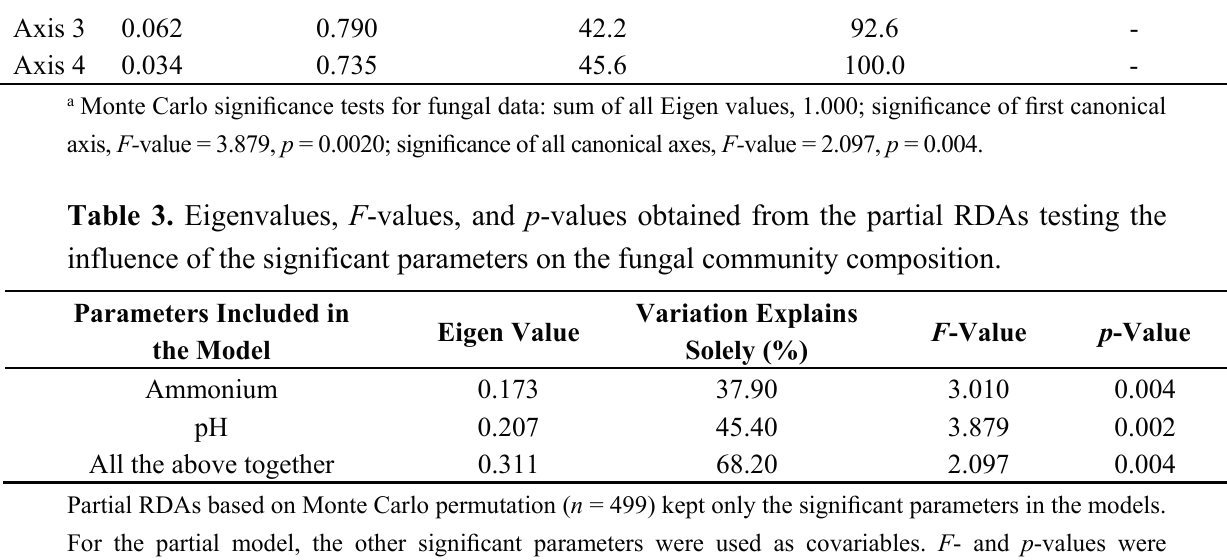
Table 2. Redundancy analysis results of surface and bottom fungal DGGE pro fi les a . Cumulative % Cumulative % Sum of All Eigen Species-Environment Variations of Variations of Canonical Axis Value Correlation Species Species-Environment Eigenvalue - - - - - 0.456 Axis 1 0.279 0.864 27.9 61.3 - Axis 2 0.081 0.865 36.0 79.0 - Axis 3 0.062 0.790 42.2 92.6 - Axis 4 0.034 0.735 45.6 100.0 -